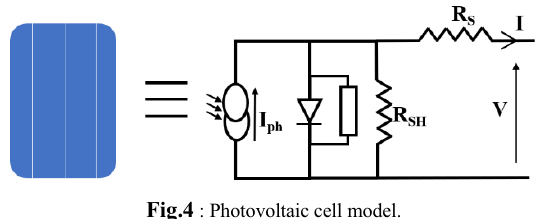
Fig.4 : Photovoltaic cell